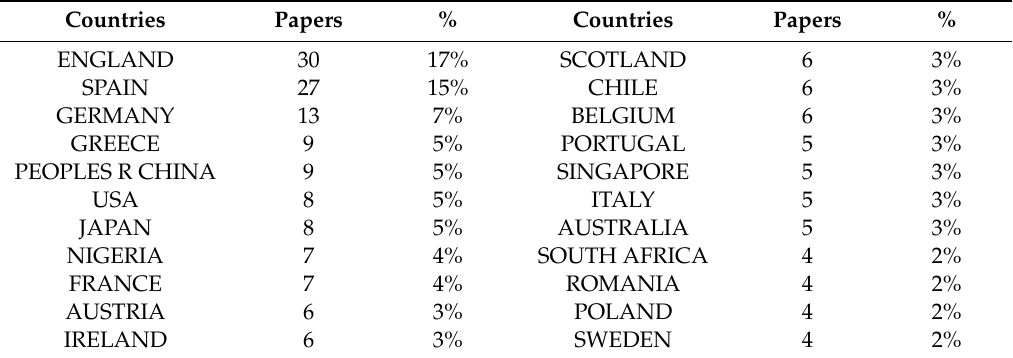
Table A1. Papers published by country (individual contribution greater than 2% of total of papers). Countries Papers